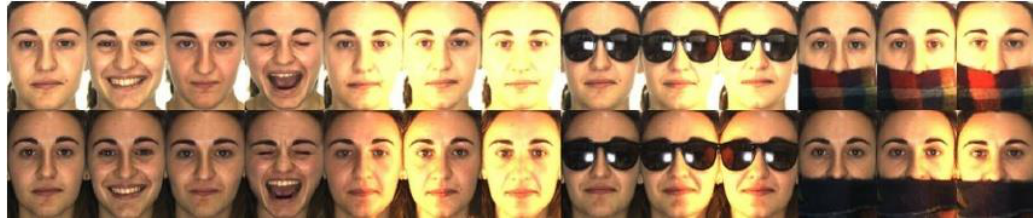
Figure 7. Examples from the AR (Alex and Robert) database.